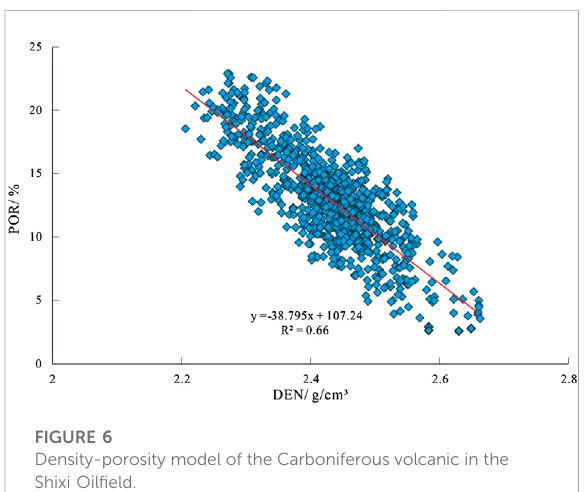
FIGURE 6 Density-porosity model of the Carboniferous volcanic in the Shixi Oil fi